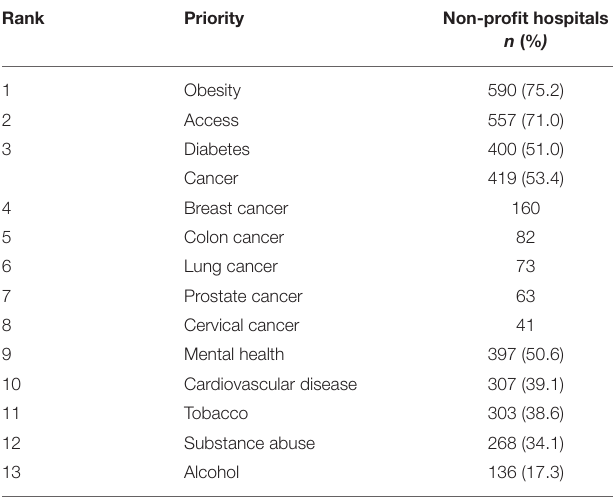
TABLE 1 | Ranking of top 13 priorities targeted in 2013 implementation